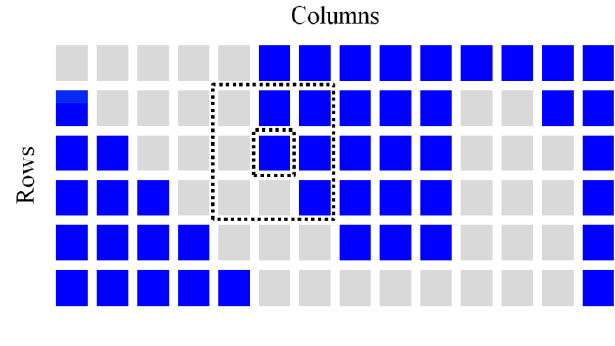
Figure 3. Schematic of the 2D projection of the data. Blue pixels represent foreground objects and grey pixels may represent the background object or empty space. A single scan point being evaluated and its corresponding adjacent area (kernel) of 3 × 3 are enclosed within dotted lines.